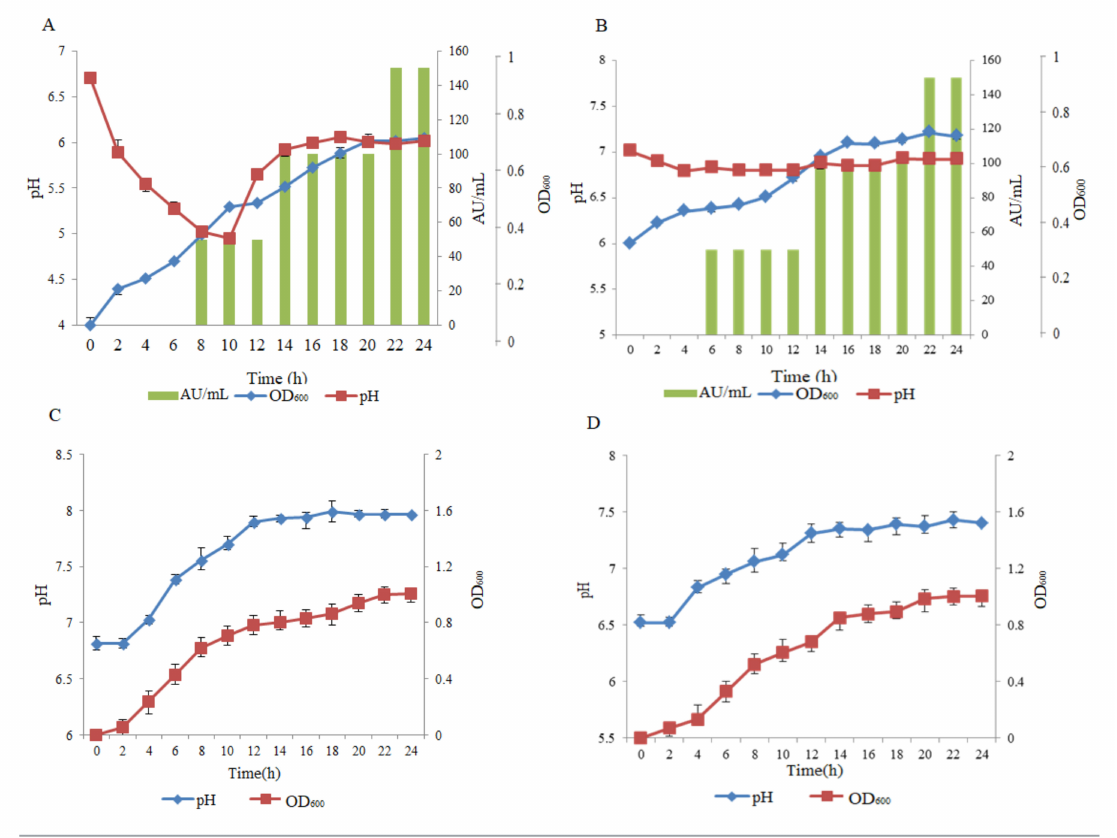
Figure 2. Time course of pantocin wh-1 production during the growth of P. dispersa W18 in: ( A ) simple 7H9 medium; ( B ) Spizizen’s medium; ( C ) LB medium; and ( D ) MH medium. The amount of pantocin wh-1 is expressed as arbitrary units per milliliter (AU / mL). The indicator strain was M. smegmatis mc 2